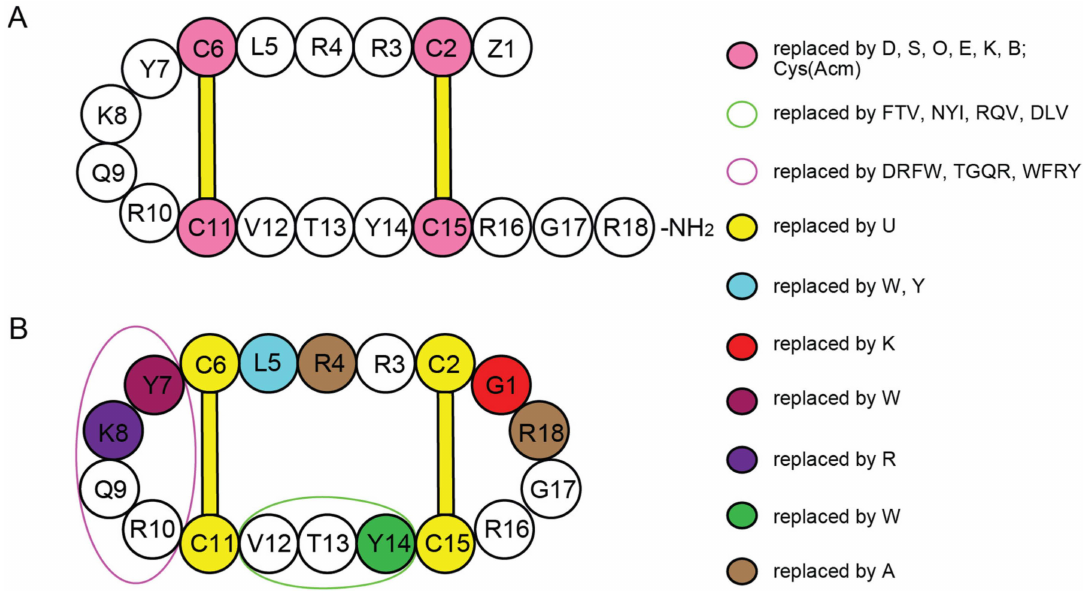
Figure 7. Residue modifications of Gm and cGm analogues. ( A ) Gm sequence with modified residues. ( B ) cGm sequence with modified residues. The coloured circles represent modified residues. The two disulfide bonds in each peptide are shown (yellow). Three residues replacement are highlighted with a green circle and four residues replacement are highlighted with a purple circle. A, alanine; B, diaminopropionic acid; C, cysteine; D, aspartic acid; E, glutamic acid; F, phenylalanine; G, glycine; I, isoleucine; K, lysine; L, leucine; N, asparagine; O, ornithine; Q, glutamine; R, arginine; S, serine; T, threonine; U, selenocysteine; V, valine; W, tryptophan; Y,